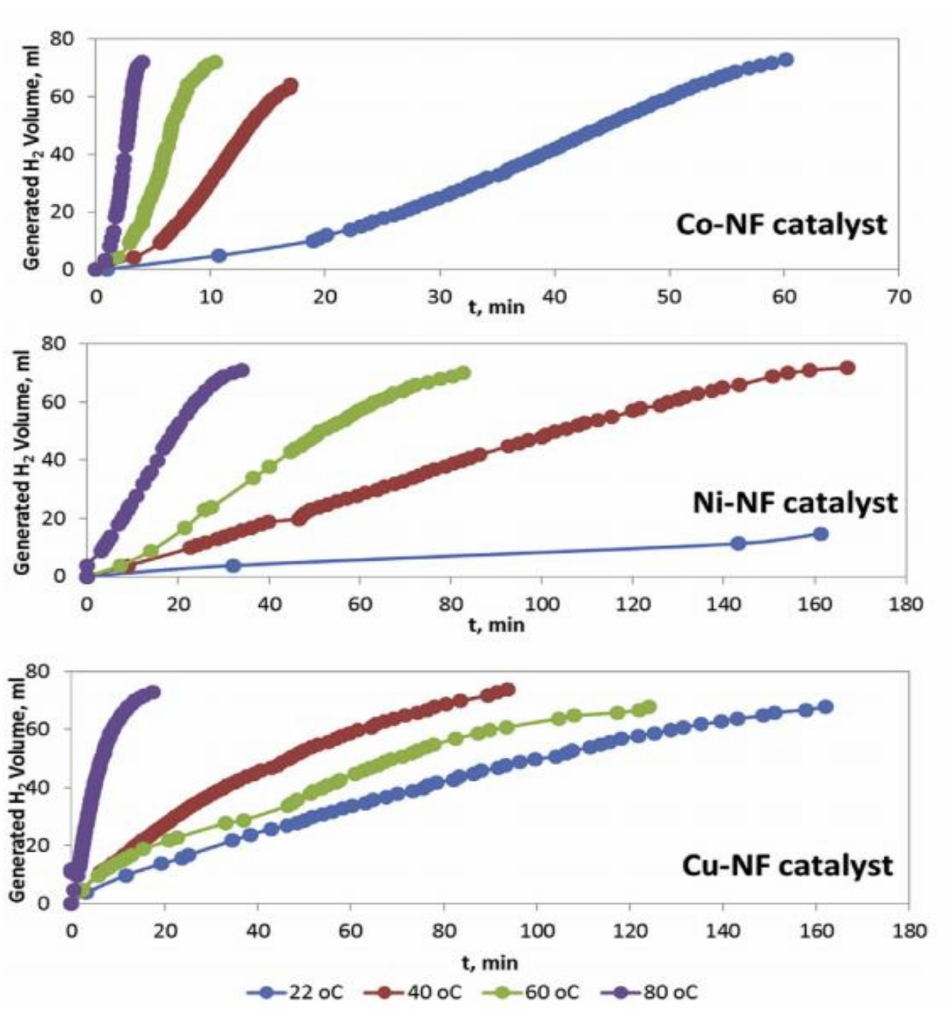
Figure 24. Catalytic performance of CoO, NiO, and CuO NFs at different temperatures in AB hydrolysis reaction. Reprinted from reference [17] with permission from